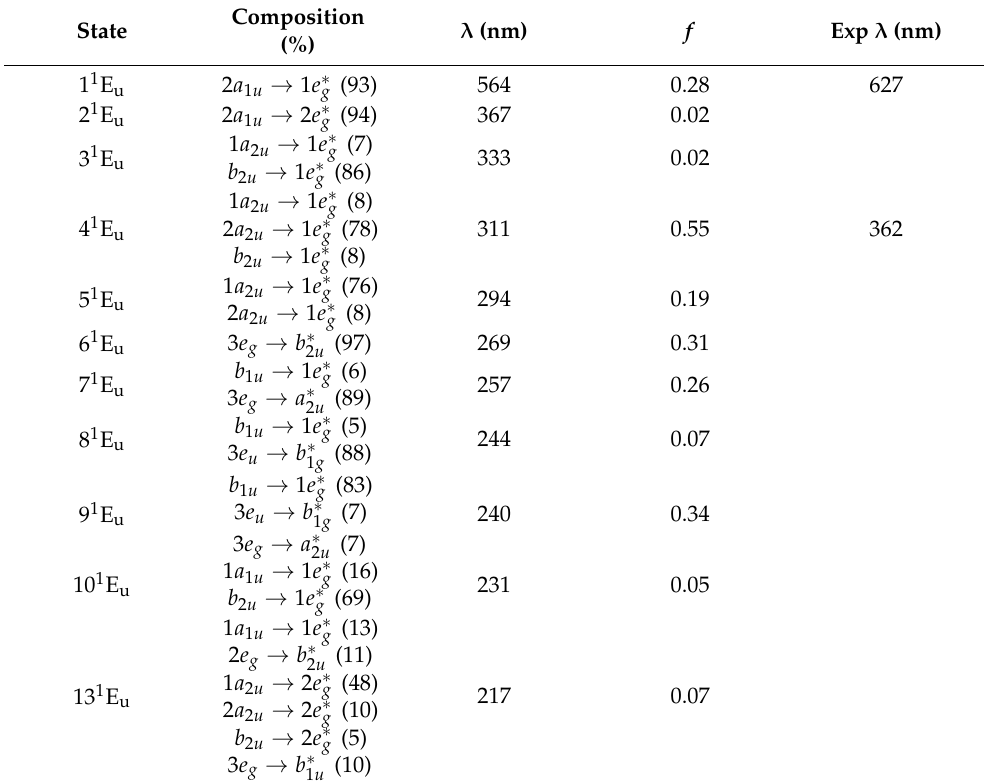
Table 5. Calculated composition of the lowest excited states and corresponding oscillator strengths for NiTTDPz